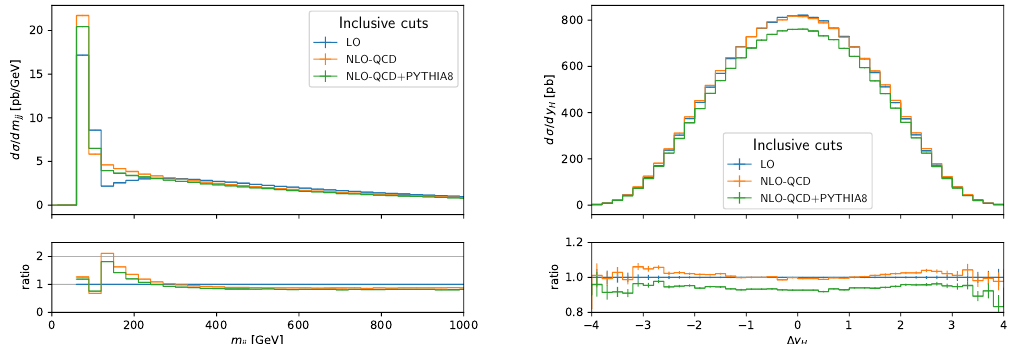
Figure 1 . Invariant-mass distribution of the two tagging jets (left) and rapidity of the Higgs boson (right) at LO (blue), NLO-QCD (red) and NLO-QCD+PS (green) accuracy within the inclusive cuts of eqs. (3.3)–(3.4). The ratios of the NLO-QCD to the LO (red) and of the NLO-QCD+PS to the LO results (green) are shown in the respective lower